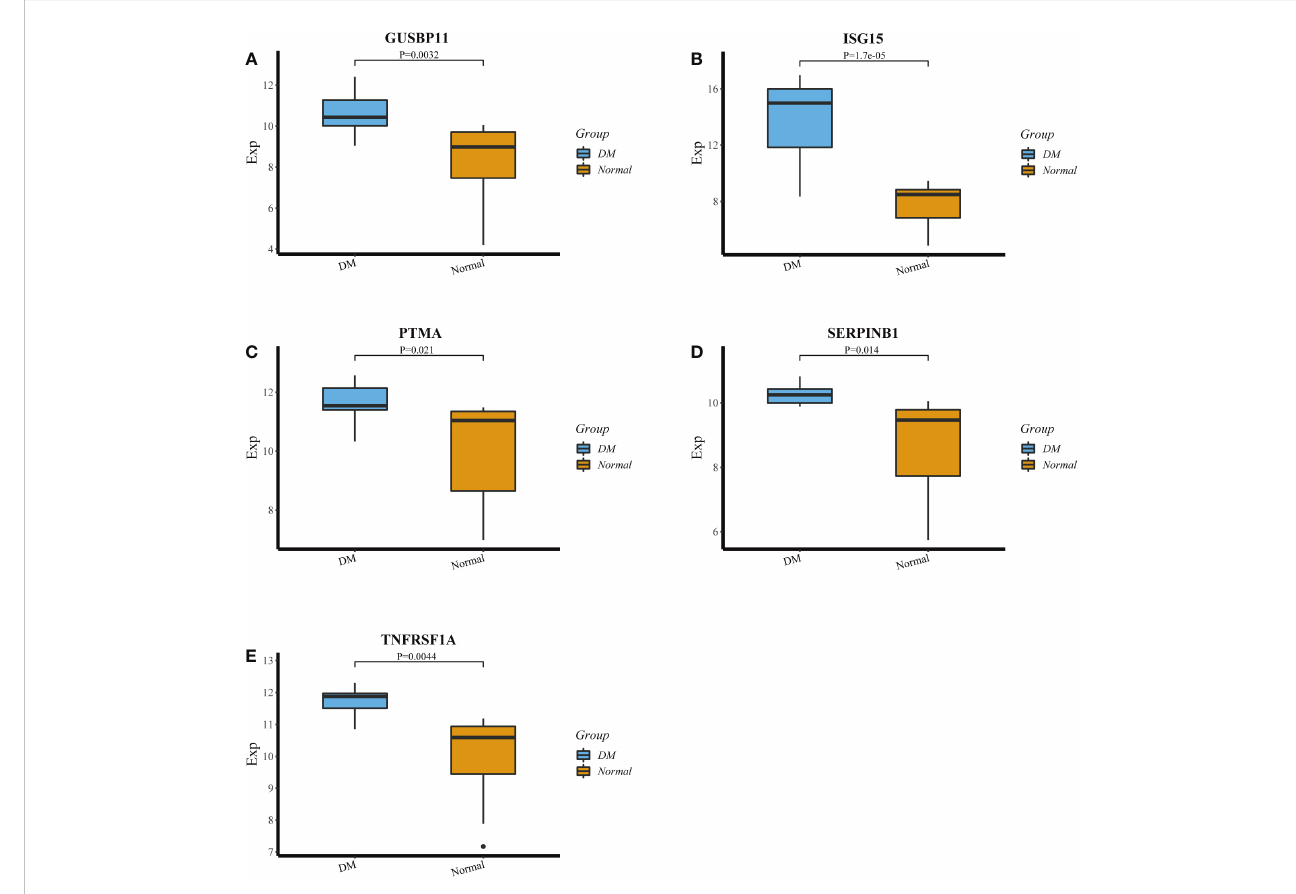
FIGURE 5 (A ‐ E) The expression of GUSBP11,ISG15 , PTMA , SERPINB1 and TNFRSF1A in DM group and healthy